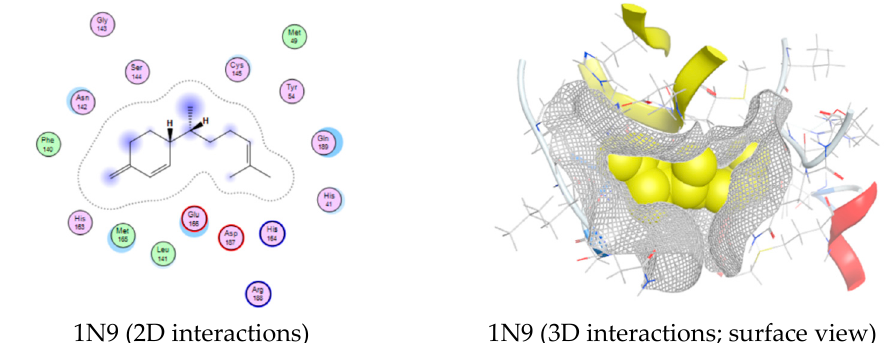
Figure 2. Docked images of the most active molecules. Ligand interactions within the active site pocket of the protein 6LU7, shown as 2D and 3D interactions; surface view inside the active site pocket.